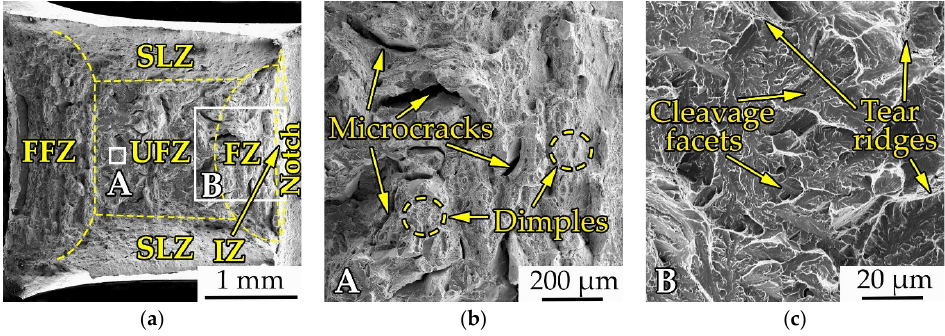
Figure 12. SEM images of fracture surface samples after THT after impact test at 28 °C ( a ) and magnified areas marked by white squares at a ( b , c ). IZ—crack initiation zone, FZ—fibrous zone, UFZ—unstable fracture zone, SLZ—shear lip zone, FFZ—final fracture zone.